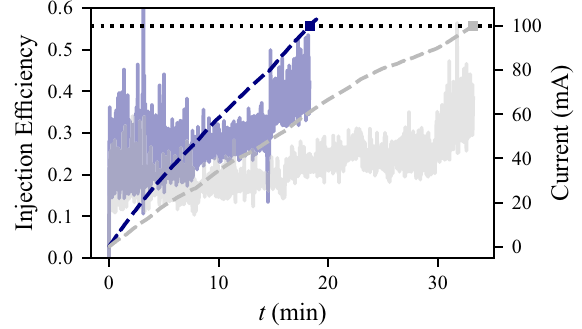
FIG. 8. Beam injection up to 100 mA using BO result (navy) compared to the manual tuning result (grey) obtained from an operation day. The dashed lines are the accumulated current of BO and manual tuning result. BO was roughly twice as fast as the manual tuning, greatly reducing the required beam injection